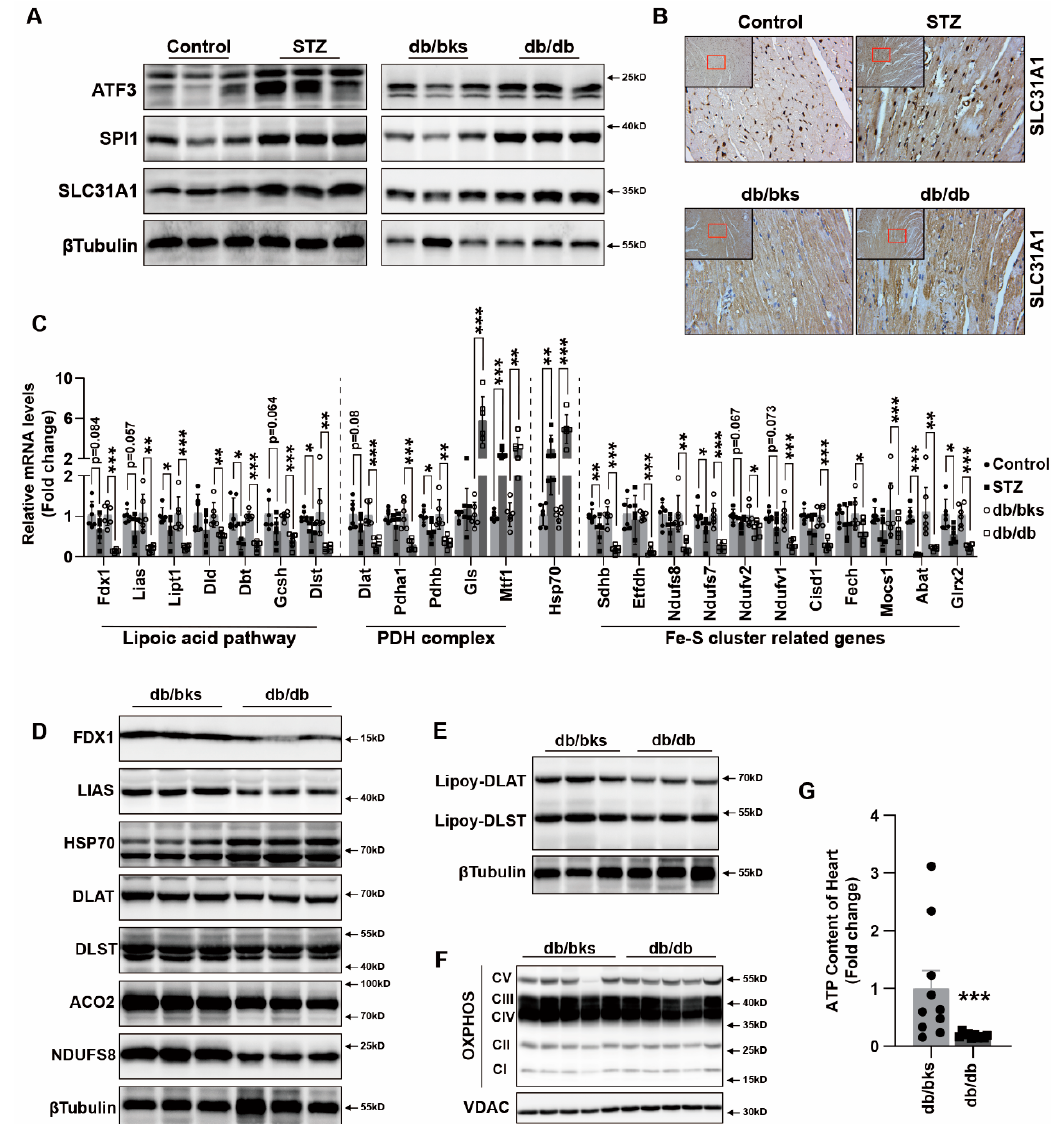
Figure 6. ATF3/SPI1/SLC31A1 signaling of cuproptosis involved in myocardium injury of diabetic mice. ( A ) Western blot analysis of ATF3/SPI1/SLC31A1 signaling of cuproptosis in myocardial tissue of diabetic mice ( n = 3). ( B ) SLC31A1 expression of myocardial tissue in diabetic mice by IHC. ( C ) mRNA levels of cuproptosis and iron–sulfur cluster (Fe–S) gene in heart of STZ-induced and db/db- diabetic mice ( n = 6). ( D ) Western blot analysis of Fe–S cluster proteins in myocardial tissue of diabetic mice ( n = 3). ( E ) Western blot analysis of lipoylation of DLAT and DLST in myocardial tissue of diabetic mice ( n = 3). ( F ) Western blot analysis of the mitochondrial oxidative phosphorylation complex in myocardial tissue of diabetic mice ( n = 5). ( G ) ATP content in myocardial tissue of diabetic mice ( n = 10). * p < 0.05, ** p < 0.01, *** p < 0.001.